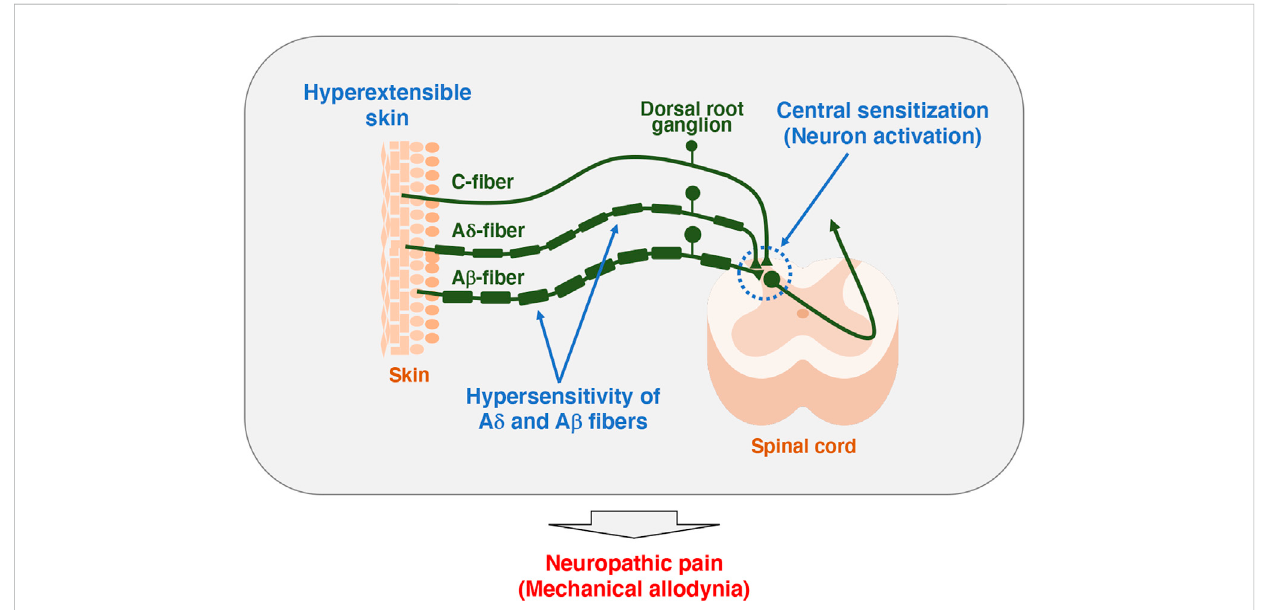
FIGURE 2 Model of pathogenesis for mechanical allodynia in Tnxb − / − mice. Somatosensory information is detected in the primary afferent fi bers extending to theskin,whichinturnistransmittedtothespinalcordandthentothebrain.UnmyelinatedC- fi bersandlightlymyelinatedA δ - fi bersconductnoxiousand thermal signals, whereas myelinated A β - fi bers conduct innocuous signals such as touch and pressure (Moehring et al., 2018). Tnxb − / − mice exhibited increased sensitivity to innocuous mechanical stimuli but not thermal stimuli, indicating the induction of mechanical allodynia (Okuda-Ashitaka et al., 2020). Likewise, Tnxb − / − mice showed hypersensitization of myelinated A δ - and A β - fi bers but not C- fi bers. Furthermore, levels of activated neuron markers,phosphorylationofextracellularsignal-relatedkinaseandNADPH-diaphoraseactivityofneuronalnitricoxidewereincreasedinthespinaldorsal hornof Tnxb − / − micecomparedtothoseinwild-typemice.Thus,TNXde fi ciencyisinvolvedinmechanicalallodyniaassociatedwithhypersensitizationof myelinated A δ - and A β - fi bers and central sensitization of the spinal